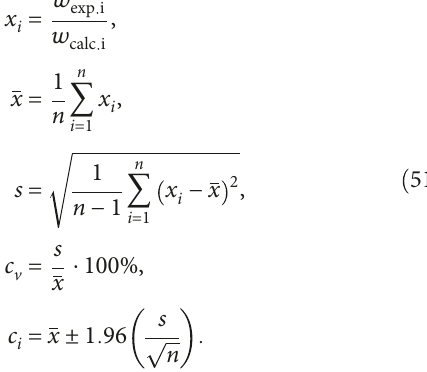
Figure 12: Comparison of the crack width estimation results with experimental ones at service load: (a) ϑ b , h = 1 ; (b) ϑ b , h from (50). Table 4: Statistical parameters of crack width